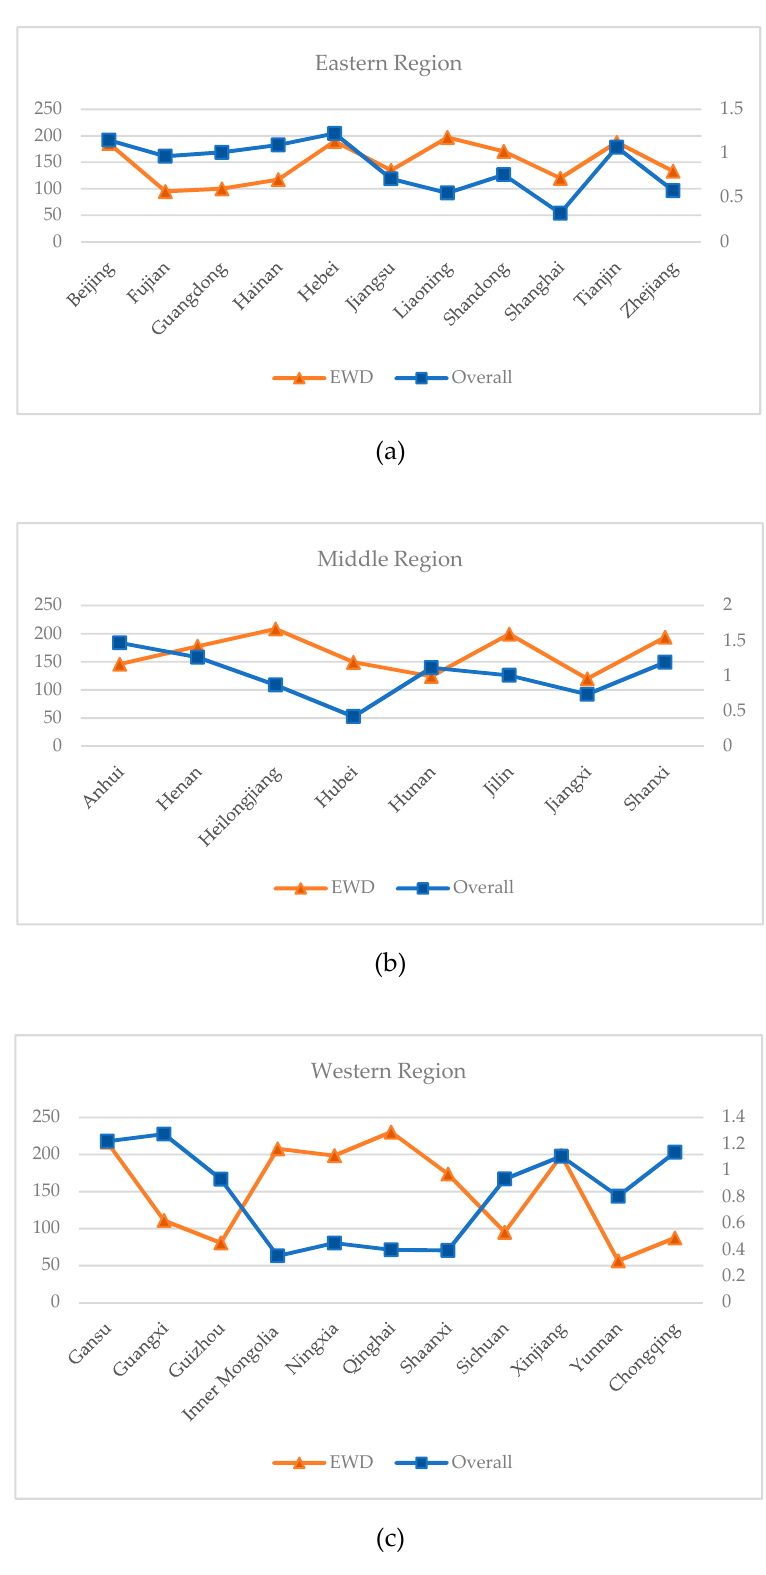
Figure 6. Line charts of EWD and overall agricultural production e ffi ciency (China). ( a ) East; ( b ) Middle; ( c ) West.